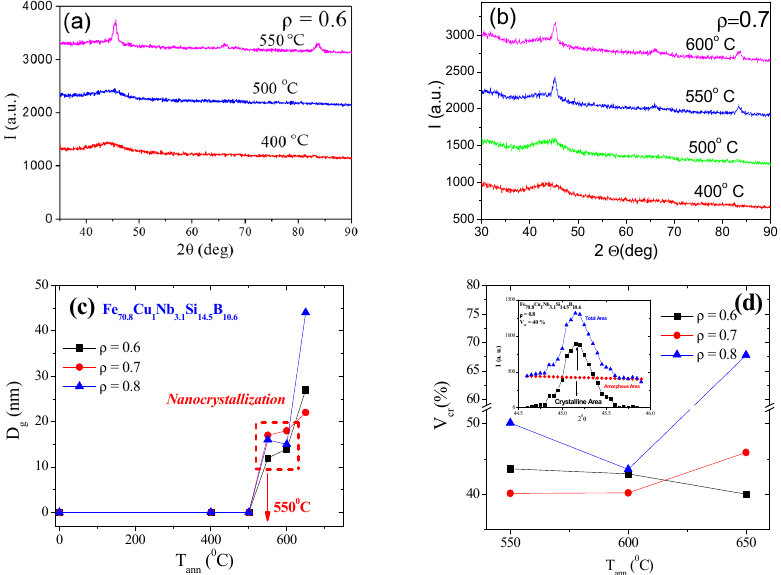
Figure 6. XRD patterns of annealed Fe 70.8 Cu 1 Nb 3.1 Si 14.5 B 10.6 glass-coated microwires at T ann ranging between 400–600 °C for 1 h for ρ -ratio = 0.6 ( a ); ρ -ratio = 0.7 ( b ); grain size, D g , dependence on T ann ( c ), and crystalline volume fraction V cr dependence on T ann of Fe 70.8 Cu 1 Nb 3.1 Si 14.5 B 10.6 microwires for different ρ -ratios ( d ). Inset of ( d ) shows the determination of V cr from XRD crystalline peak of annealed Fe 70.8 Cu 1 Nb 3.1 Si 14.5 B 10.6 at 650 °C with ρ -ratio = 0.8. Reproduced from reference [47], Figure 3.